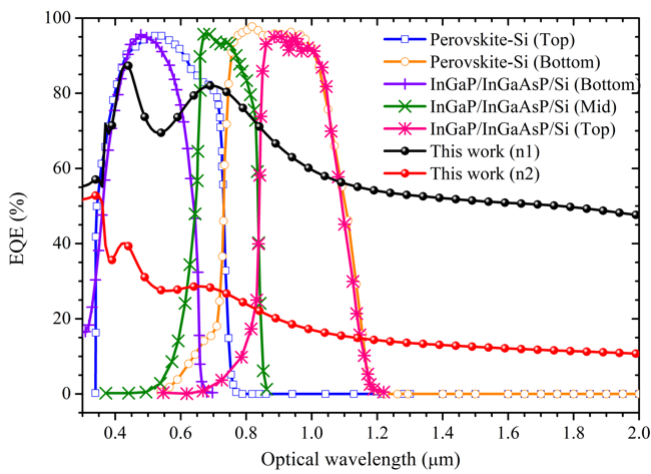
Figure 8. EQE performance with n 1 = 1 × 10 17 cm − 3 and n 2 = 1 × 10 19 cm − 3 [65]. Table 3. Comparison of VOC, JSC, FF, and Efficiency of the solar cell structure without polarization effect.